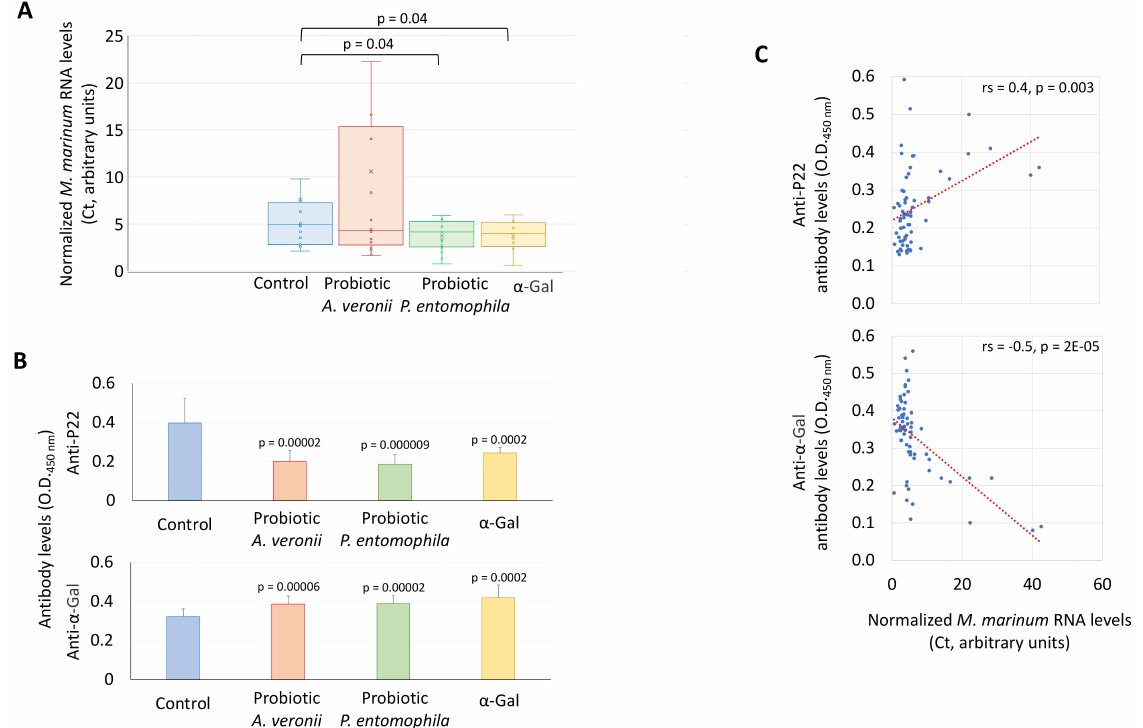
Figure 4. Effect of probiotic treatment and challenge with M. marinum on the zebrafish mycobacterial infection levels and antibody response. ( A ) Mycobacterium RNA levels were characterized by RT-qPCR in immunized and control PBS zebrafish challenged with M. marinum , normalized against D. rerio gapdh . The normalized Ct values were compared between treated and negative PBS control groups by Student’s t -test with unequal variance ( p < 0.05; n = 10–17/group). ( B ) Anti- α -Gal and P22 IgM antibody titers were characterized by ELISA in immunized and control PBS zebrafish challenged with M. marinum . The o.d. at 450 nm (mean of the duplicate well values of o.d. P22 or α -Gal–o.d. PBS control plus standard deviation, SD) were compared between treated and negative PBS control groups at T4 by Student’s t -test with unequal variance ( p < 0.005; n = 12–20/group). ( C ) Spearman’s Rho correlation analysis between antibody titers and M. marinum infection RNA levels ( p <